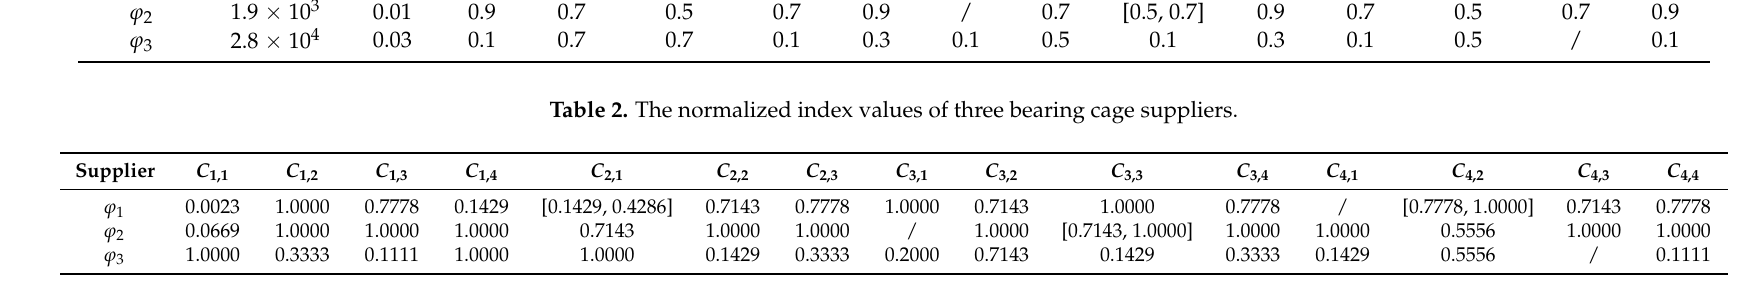
Table 3. The utility values of three bearing cage